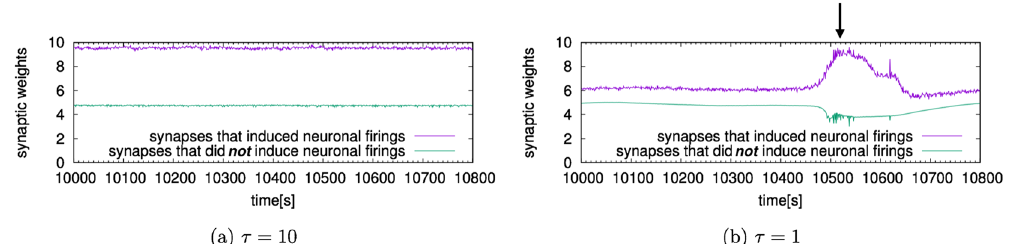
Figure 8. Temporal change in synaptic weights that induced neuronal firing. The horizontal axis represents time [s]. The vertical axis represents the synaptic weights. ( a ) The change when τ = 10 and ( b ) the change when τ = 1. The arrow shows a peak of the firing rates. When τ = 10, the two average synaptic weights fluctuate almost stationarily. When τ = 1, the synapses that induced firing become stronger and the synapses that did not induce firing become weaker near 10,500 [s]. This is simultaneous with the sudden rise of the firing rates (Fig. 4(a)) and the increase of the average amount of LTD among all synapses (Fig. 7(b)). Input from specific synapses can cause the firing rate to be high even if the amount of LTD is